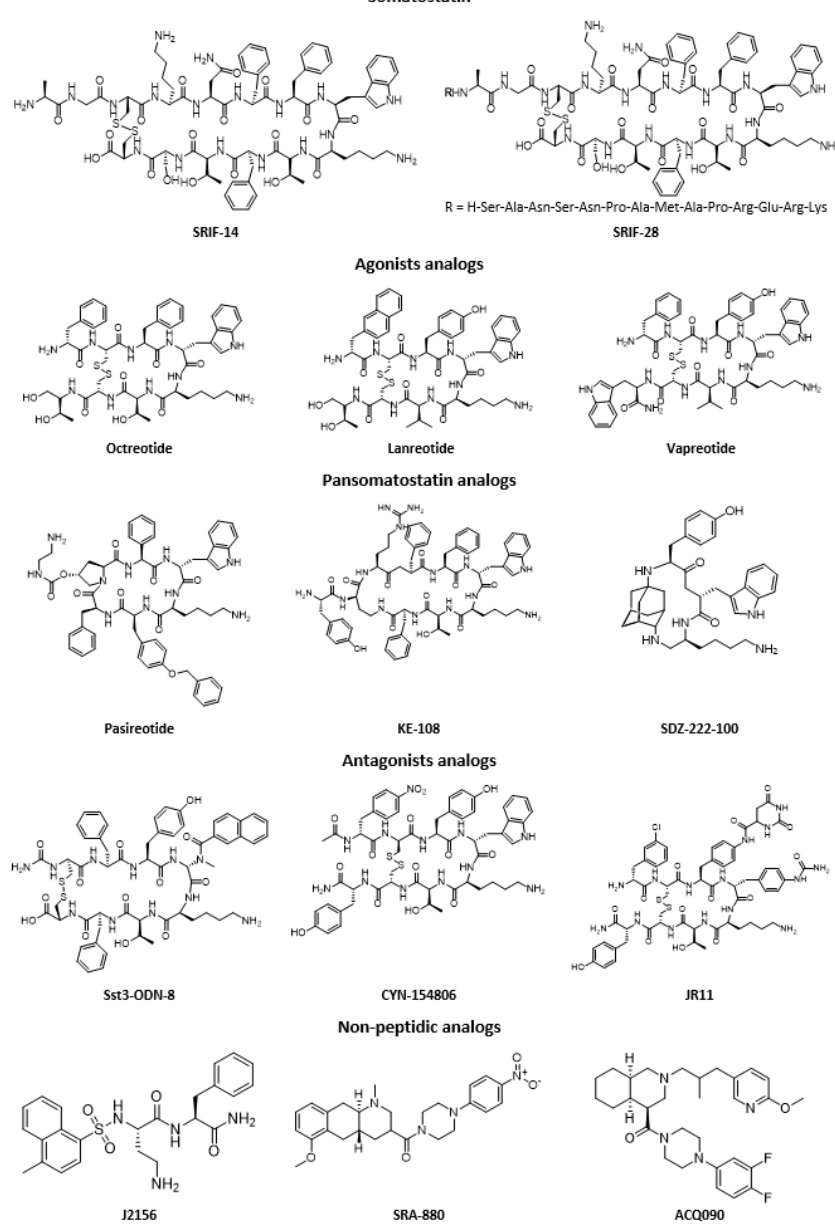
Figure 3. Chemical structures of SRIF-14, SRIF-28, and selected examples of somatostatin analogs.